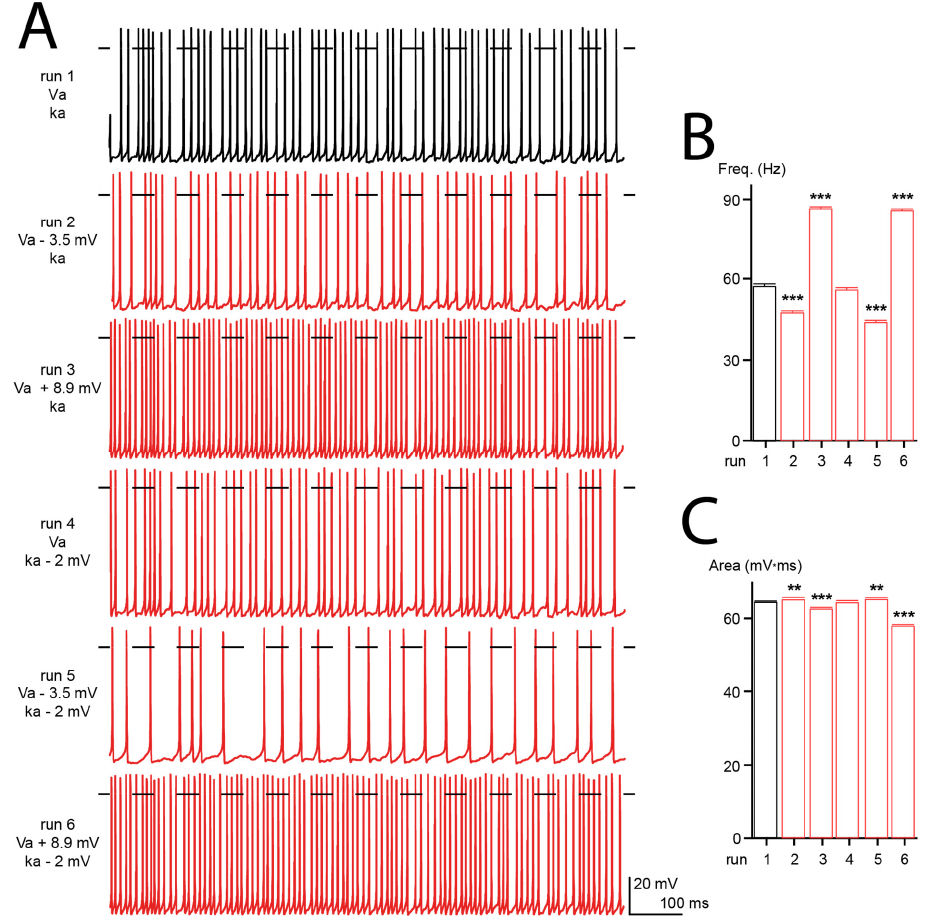
Figure 8. Computer modeling of human Purkinje cell. ( A ) Representative firing patterns obtained from simulated Purkinje cell with WT Cav2.1 properties (Va, ka, run 1), with a hyperpolarizing shift of Va (run 2), a depolarization shift of Va (run 3), an increase of ka (run 4), or a combination of both (run 5 and 6). ( B ) Bar graph showing the mean action potential frequencies (freq) obtained for the different simulations (in Hertz: 57.3 ± 0.8, 47.3 ± 1.0, 86.3 ± 0.7, 55.7 ± 0.9, 43.8 ± 0.8 and 85.5 ± 0.7 for run 1 to run 6, respectively). ( C ) Bar graph showing the mean action potential areas obtained for the different simulations (in mV.ms: 64.0 ± 0.1, 64.7 ± 0.2, 62.2 ± 0.1, 64.0 ± 0.1, 64.8 ± 0.2, 57.6 ± 0.1 for run 1 to 6, respectively). The number of action potentials analyzed was between 389 and 807. Asterisks denote significant difference vs. run 1 (** p < 0.01, *** p < 0.01) (non-paired Student’s t